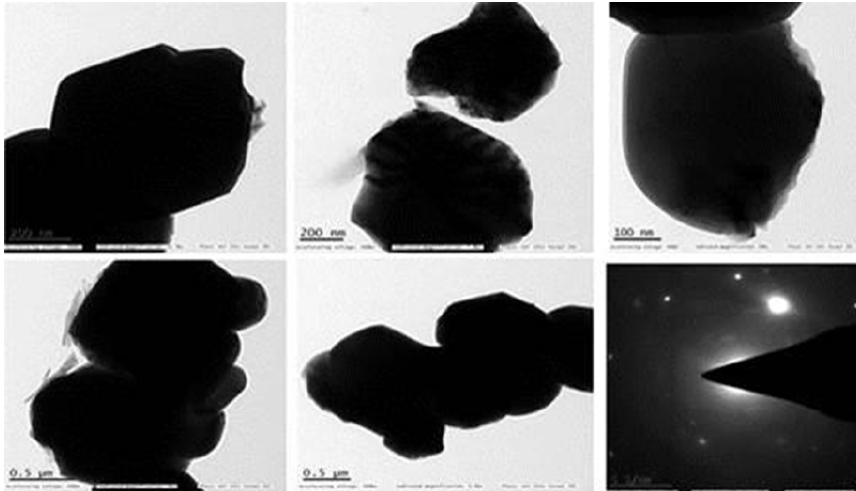
Figure 6. TEM analysis of ZnONP.